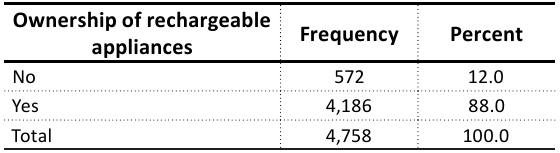
Table 10. Ownership of rechargeable appliances